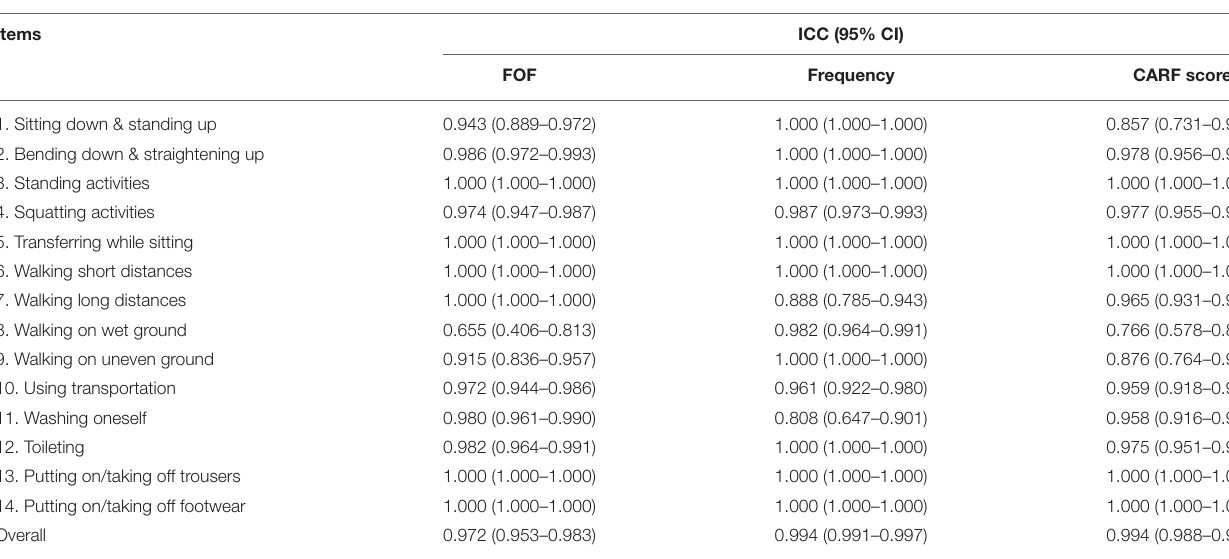
TABLE 2 | Test-retest reliability of the